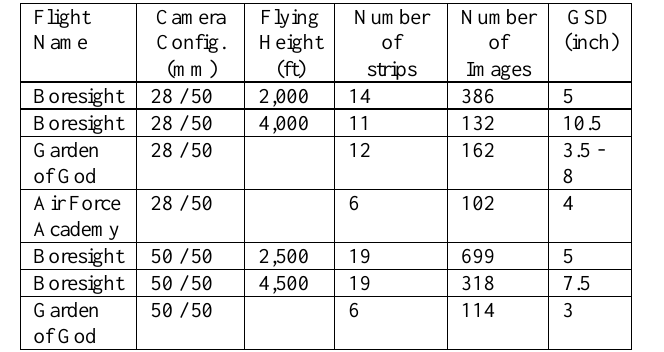
Table 4. Direct Geo Referencing (DGR) + Control